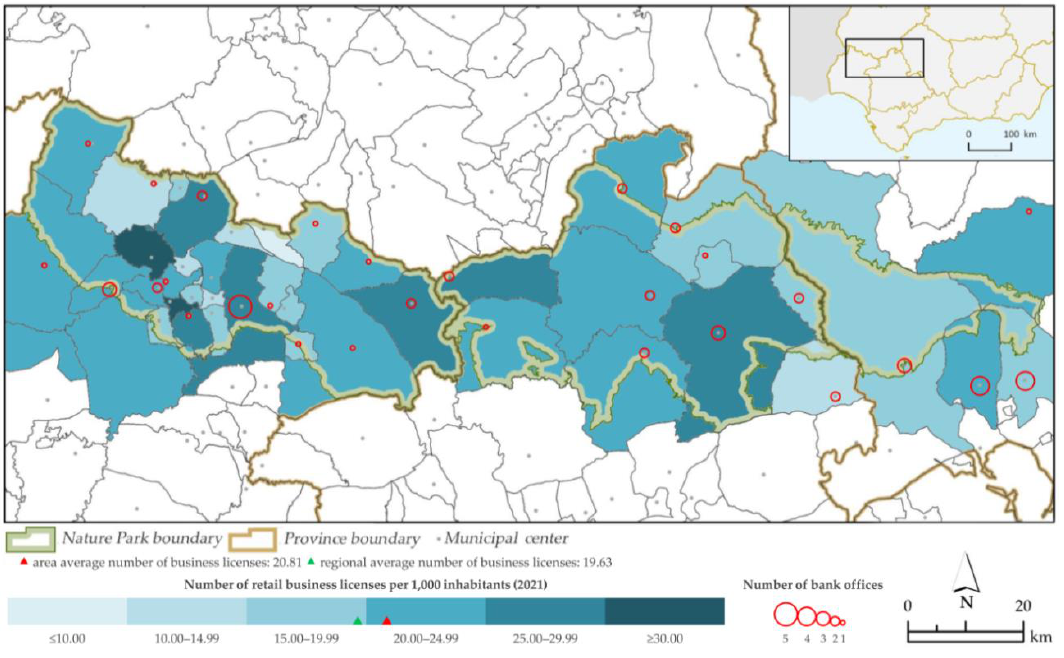
Figure 18. Private services: retail trade and bank offices. Source: [85]; authors ’ elaboration.